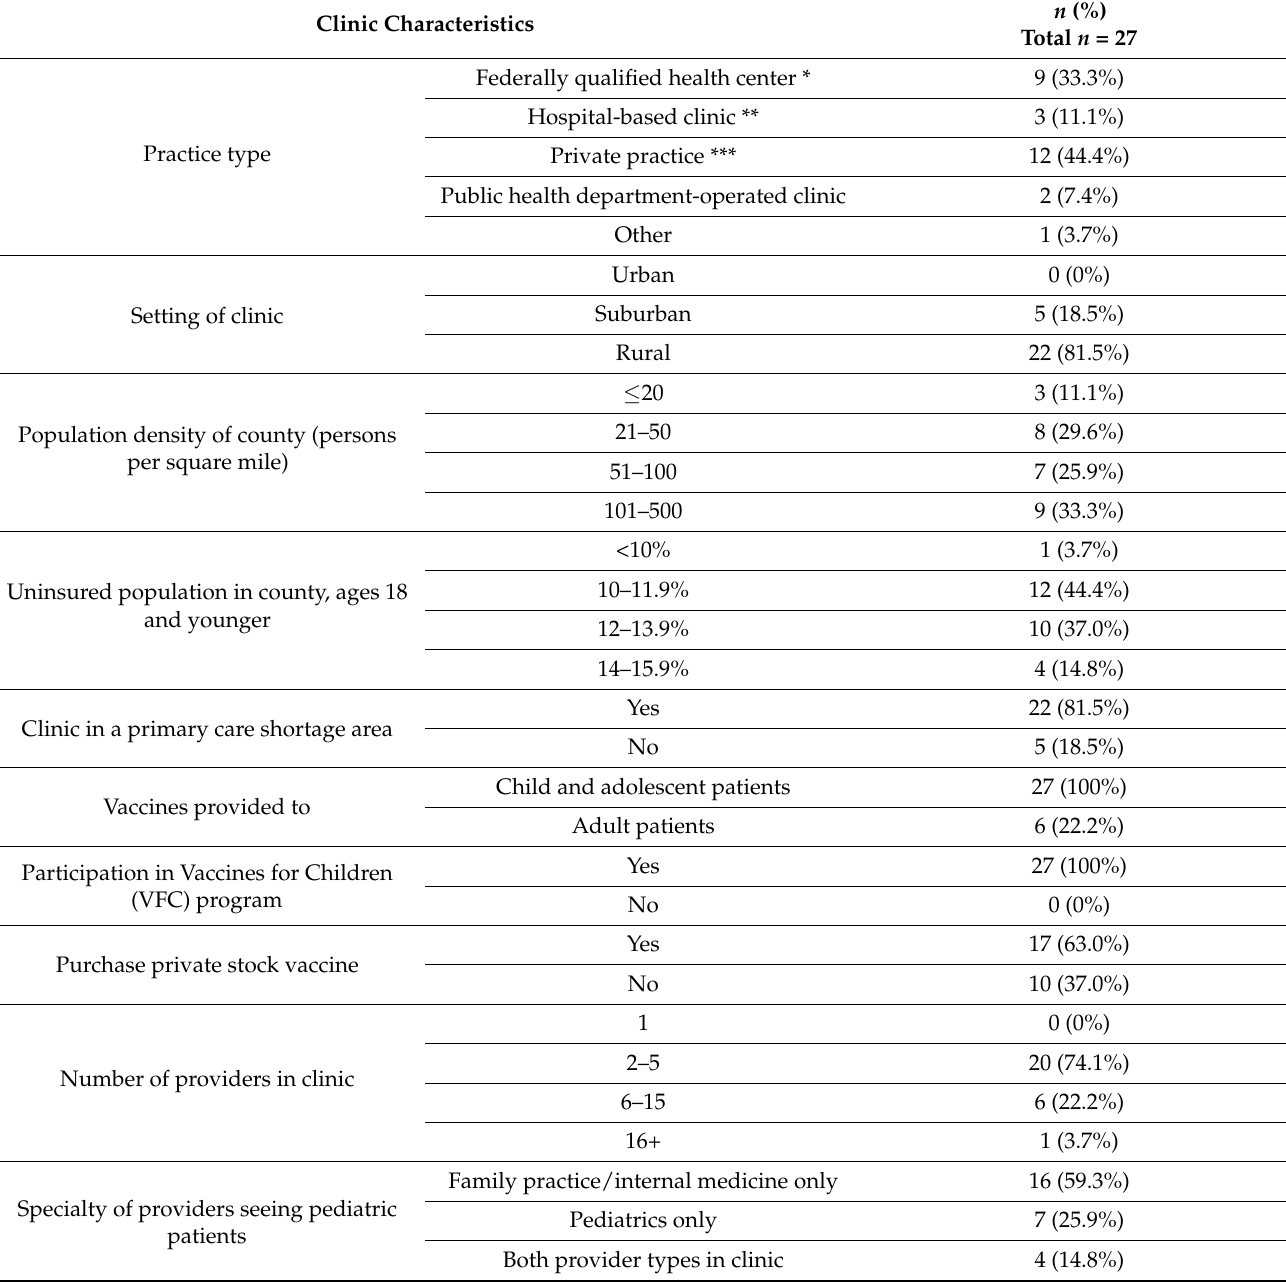
Table 1. Clinic characteristics and patient